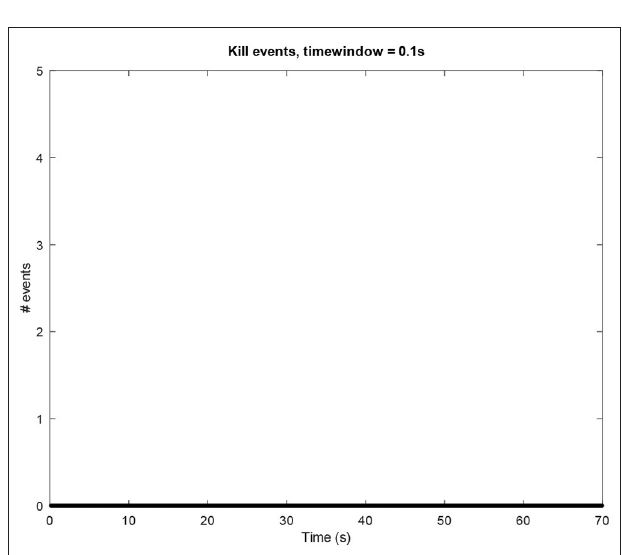
FIGURE 6 | Amount of kill events per window of time (0.1 s ) in an idle mode